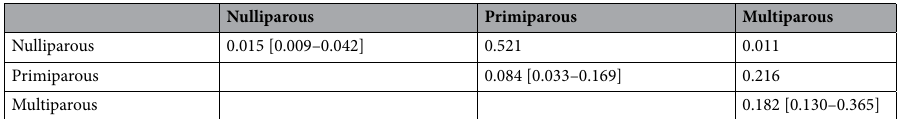
Table 2. Genetic parameters for pregnancy loss in Holstein cattle: heritability estimates in the diagonal and genetic correlations (calculated as correlations between SNP effects) above the